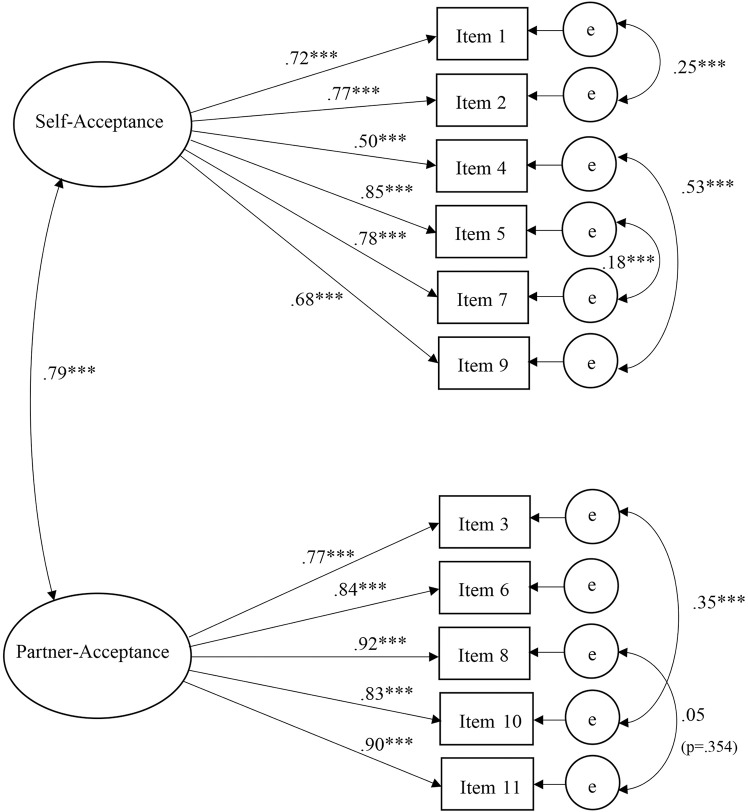
Standardized factor loadings, factor correlations and error covariances of the SIS-D.***p < .001.